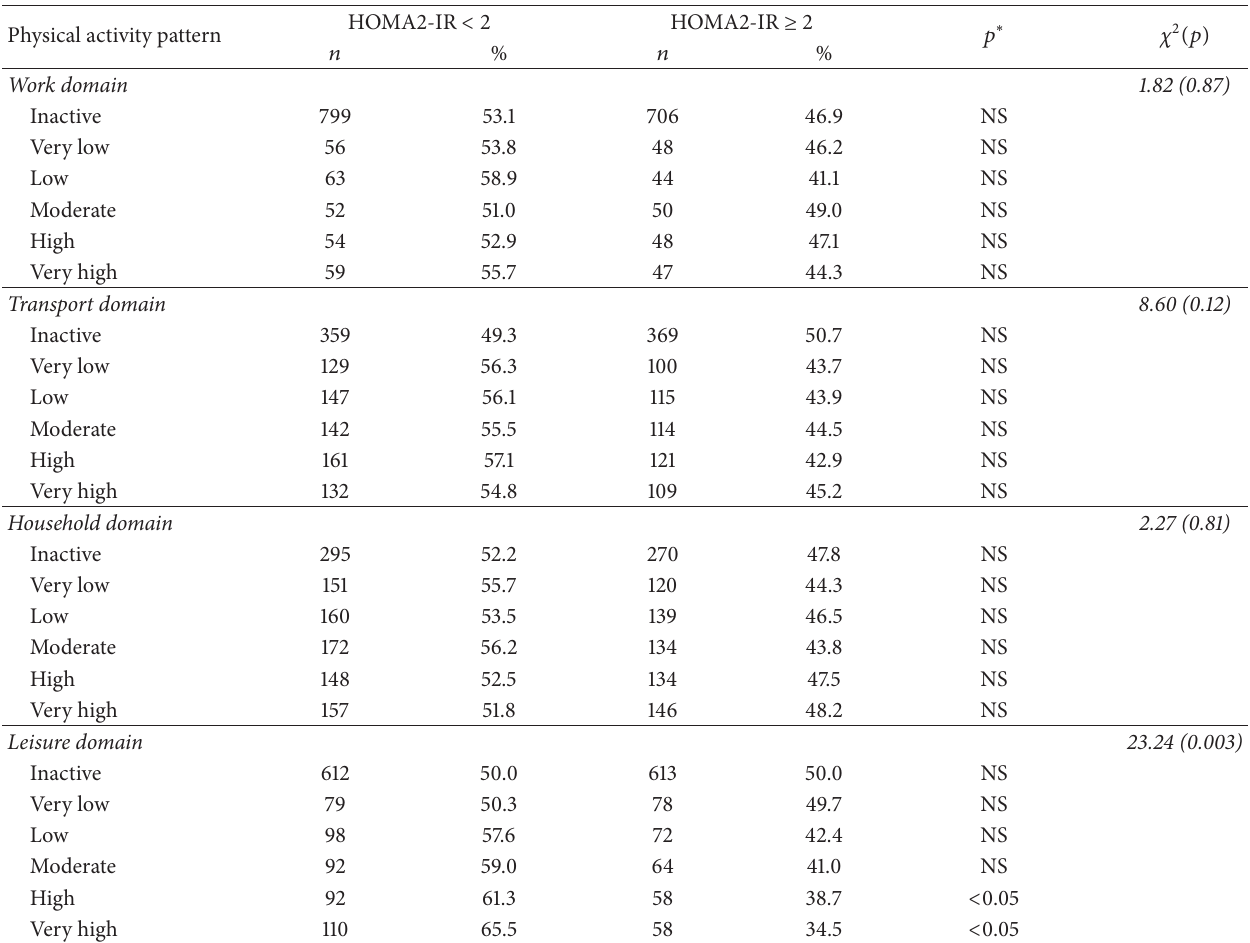
Table 5: Prevalence of insulin resistance in the general population by physical activity domains (Maracaibo, Venezuela, 2015). Physical activity